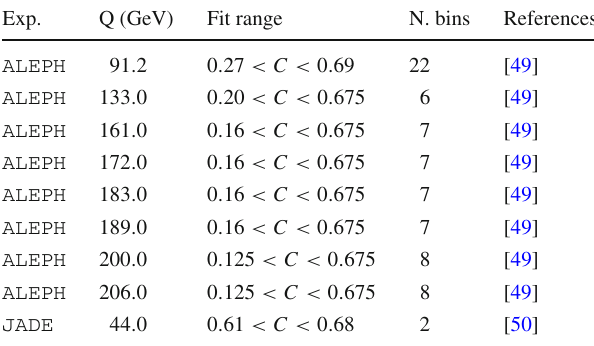
Table 1 Data set considered for the simultaneous χ 2 fit of α s and α 0